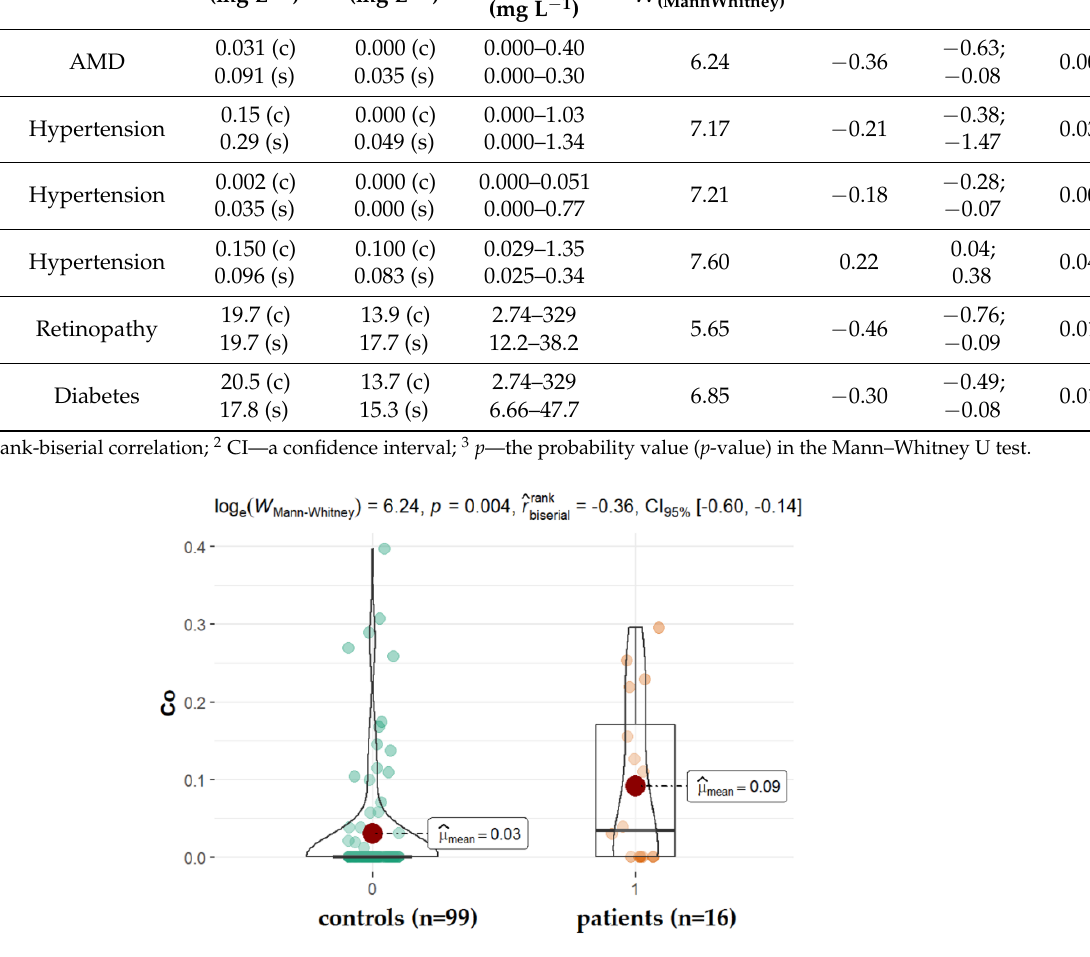
Cluster/Element Disease